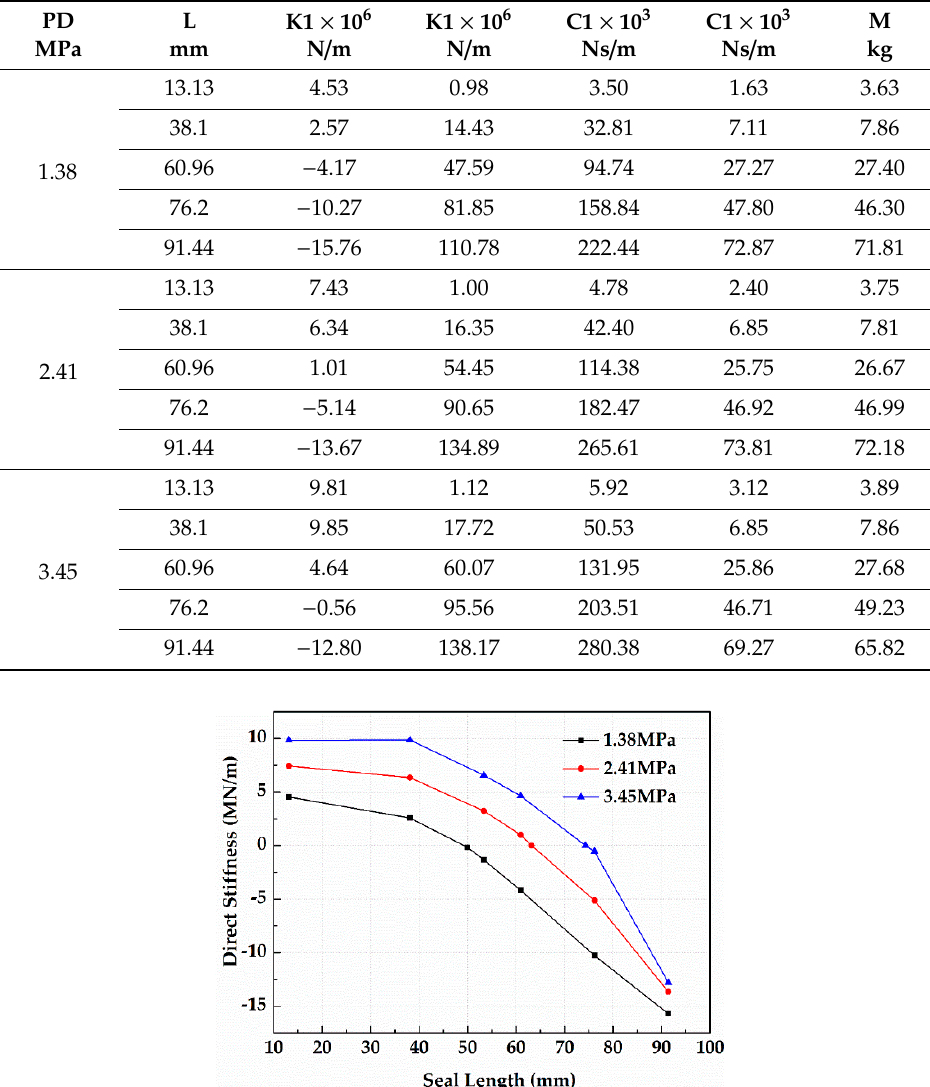
Figure 9. Leakage as a function of pressure difference. Table 2. The dynamic characteristics under di ff erent seal lengths.